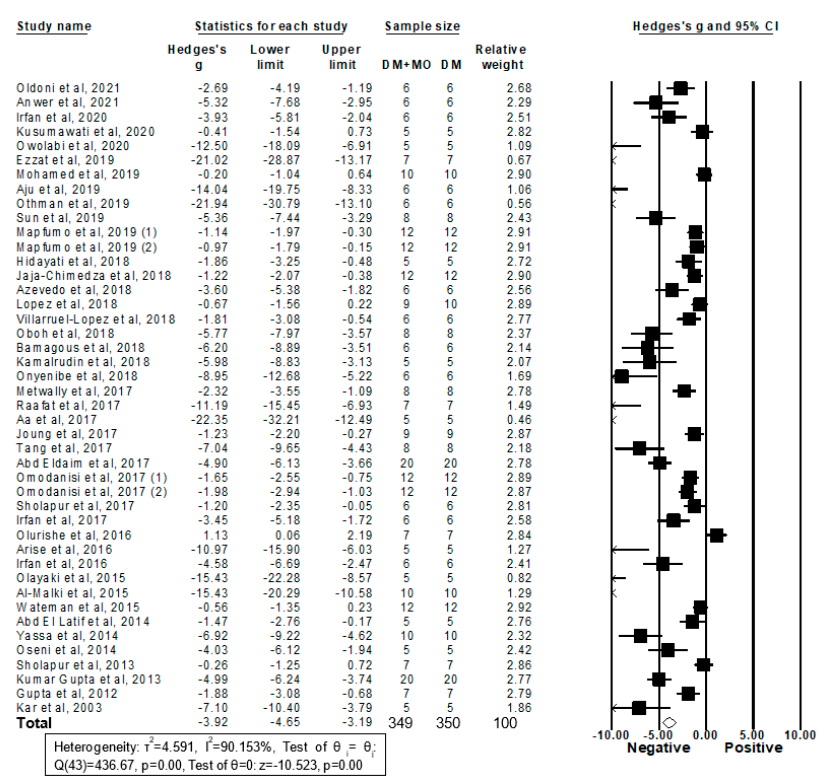
Figure 2. Meta-analysis of Hedges’ g of blood glucose levels in DM rodents with and without treatment with MO. Sum- mary estimates were analyzed using a random-effects model. CI, confidence interval. out treatment with MO. Summary estimates were analyzed using a random-effects model. CI, confidence